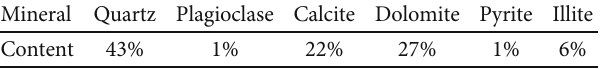
Table 1: The XRD result of the shale